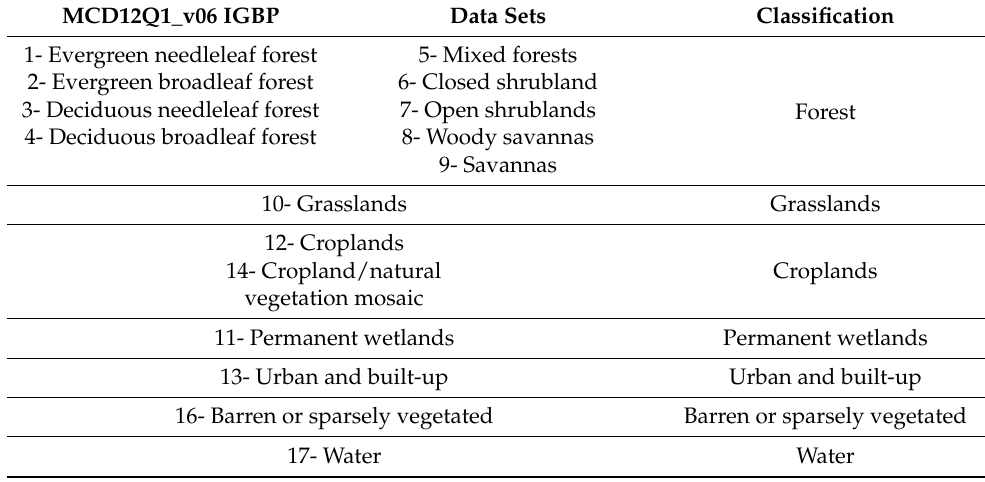
Table 1. Classification of the main land cover